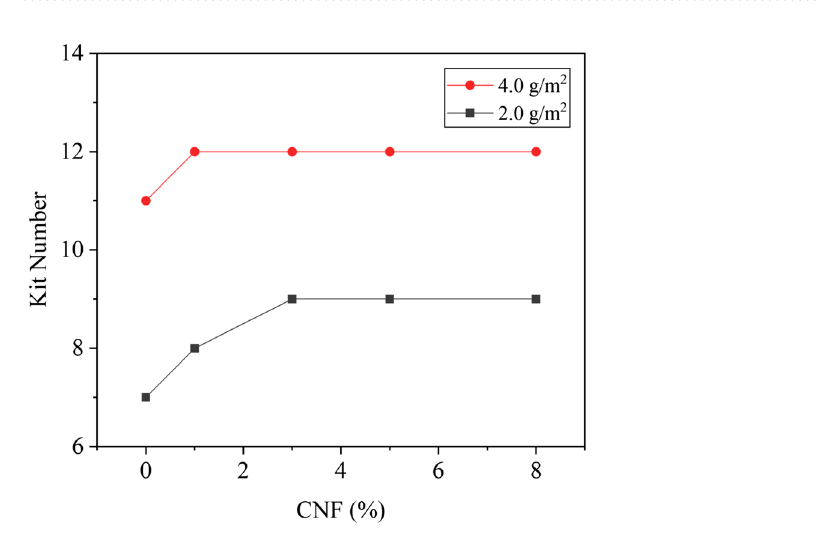
Figure 7. Effect of CNF dosage on grease resistance of